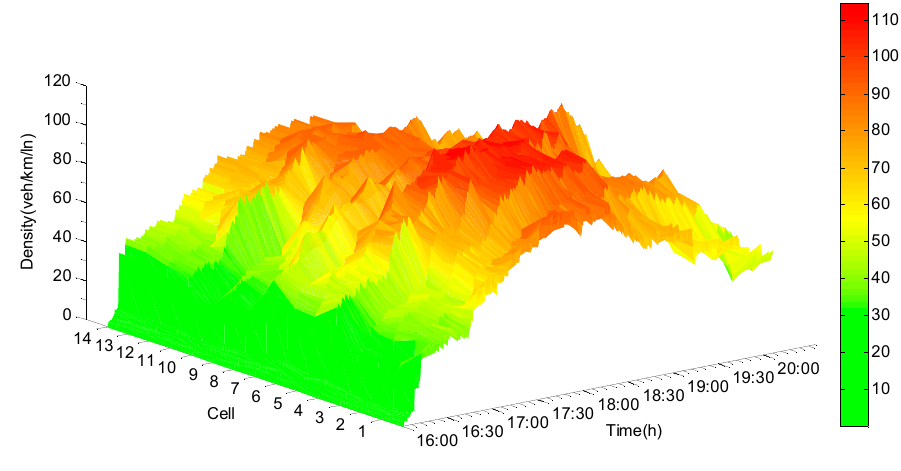
Figure 9. Estimated density of jump observer.